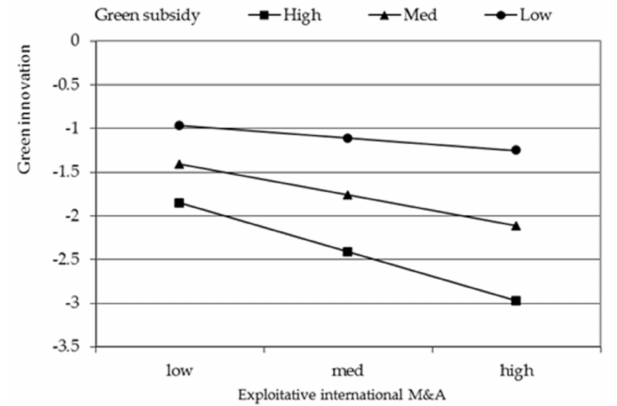
Figure 4. Moderating effect of green subsidy on the relationship between exploratory international M&A and green innovation performance.